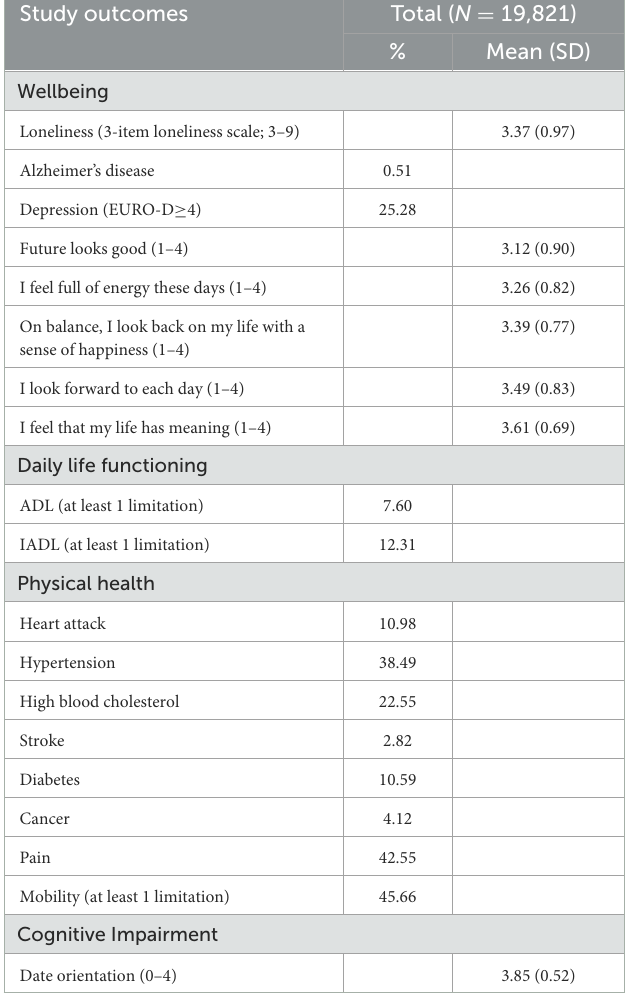
TABLE 2 Study outcomes at the study prebaseline wave (wave 4, N =